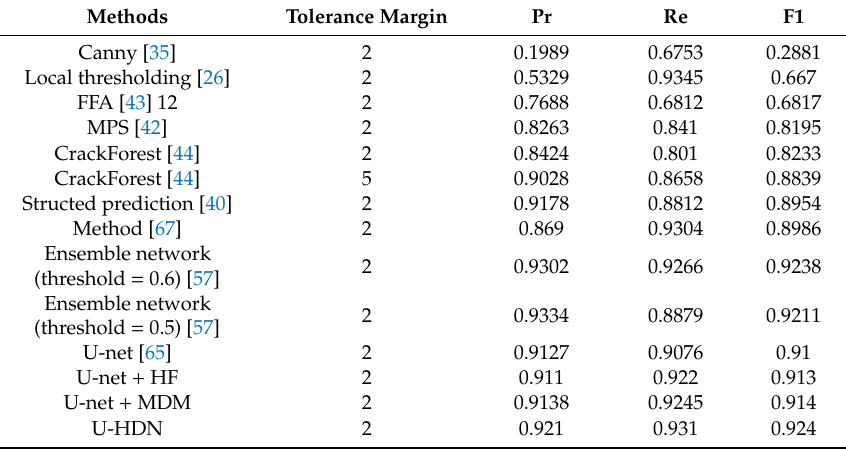
Figure 8. Results of comparison of proposed U-HDN with other method based on public database (From left to right: input image, ground truth, Canny, local threshold, FFA, MPS, structured prediction, ensemble network, and proposed U-HDN). Table 6. Crack detection results on AigleRN.